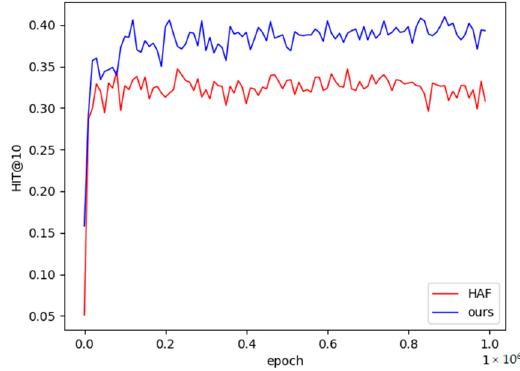
Figure 7. The 1-shot learning curve on NELL-One.